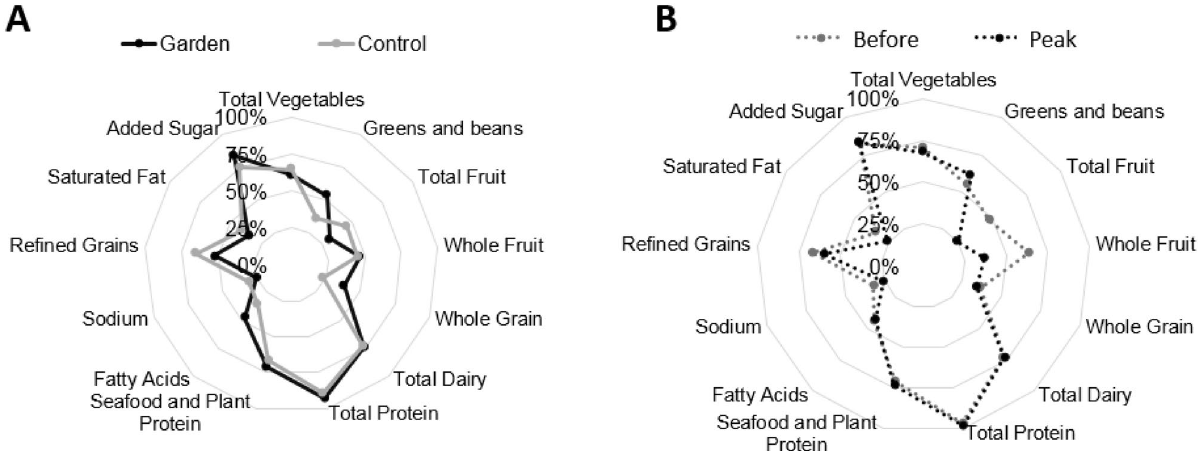
Figure 7. Radar graphs of average HEI scores between members of ( A ) the gardening and control families at peak gardening season and ( B ) within the gardening families from before the gardening season to peak gardening